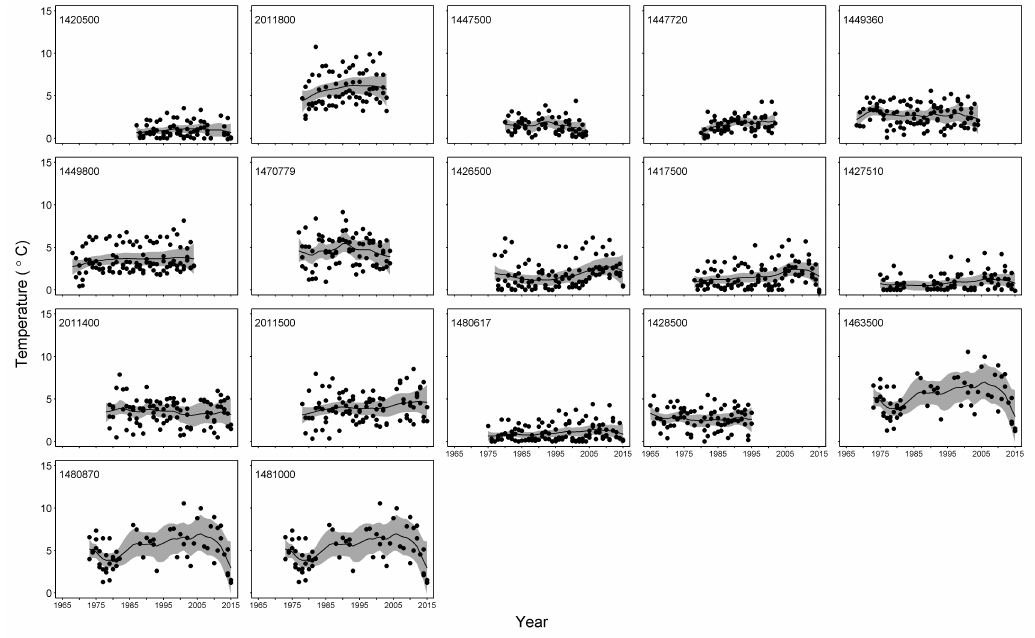
Figure 2. Temporal trends in winter river water temperature for sites located in the eastern U.S. (see Figure 1 for the site map). Solid circles are observed data; solid lines are posterior mean fitted lines; and shaded areas are 95% credible regions. Numerical codes on each panel correspond to the U.S. Geological Survey gauge